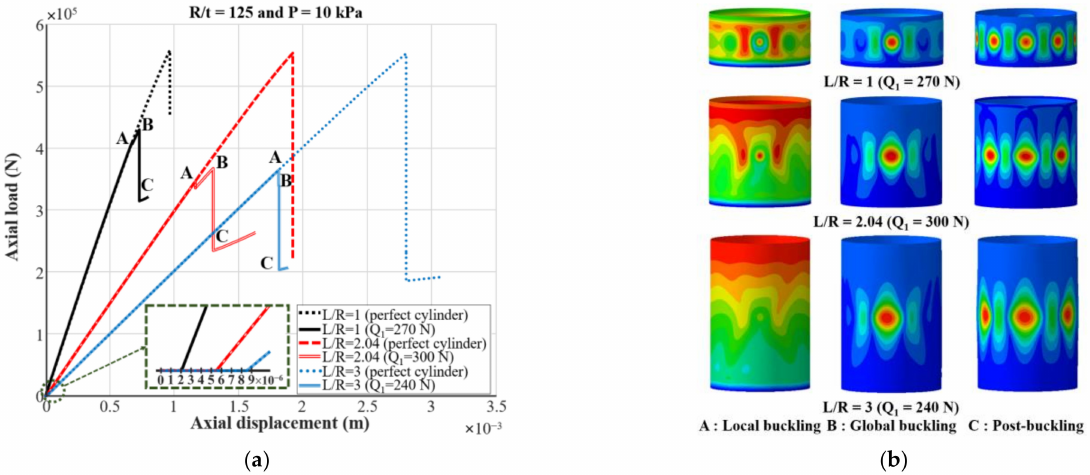
Figure 9. Post-buckling analyses results under axial compression and internal pressure (10 kPa) for the cylinders R / t = 125. ( a ) Load-displacement curves, ( b ) Buckling